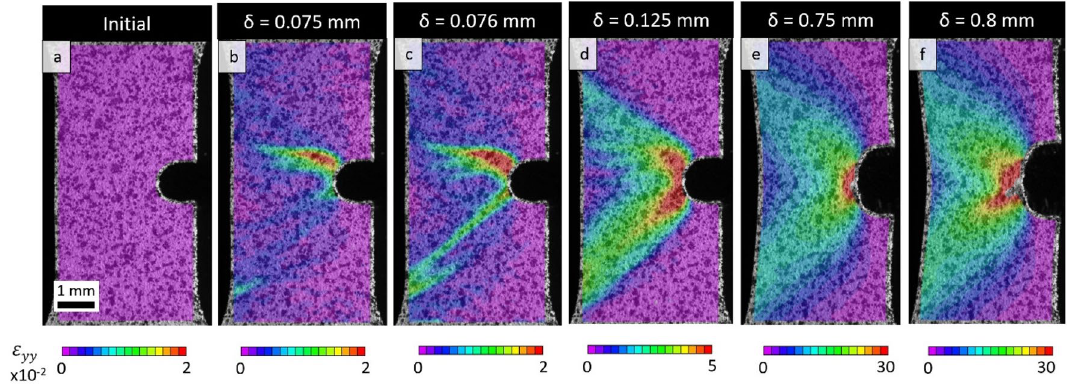
Figure 7. DIC strain fields (ε yy ) during tension of a notched specimen of as-extruded Mg–1.5Nd alloy at the following displacements (δ): ( a ) δ = 0, ( b ) δ = 0.075, ( c ) δ = 0.076, ( d ) δ = 0.125, ( e ) δ = 0.75, and ( f ) δ =